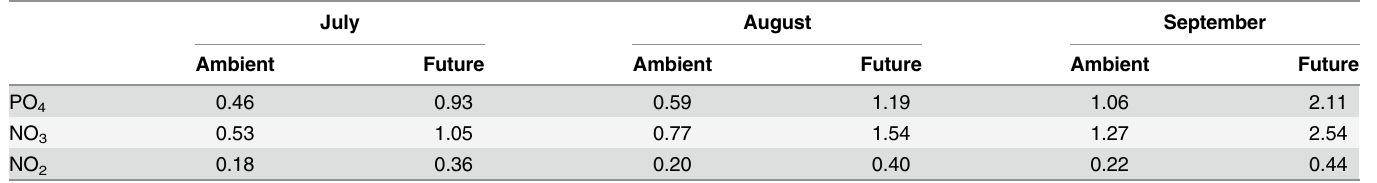
Table 1. Nutrient concentration under ambient and future conditions. “ Ambient ” nutrient concentrations of PO 4 , NO 2 , NO 3 ( μ mol L -1 ) for the respective summer months and “ future ” nutrient concentrations ( μ mol L -1